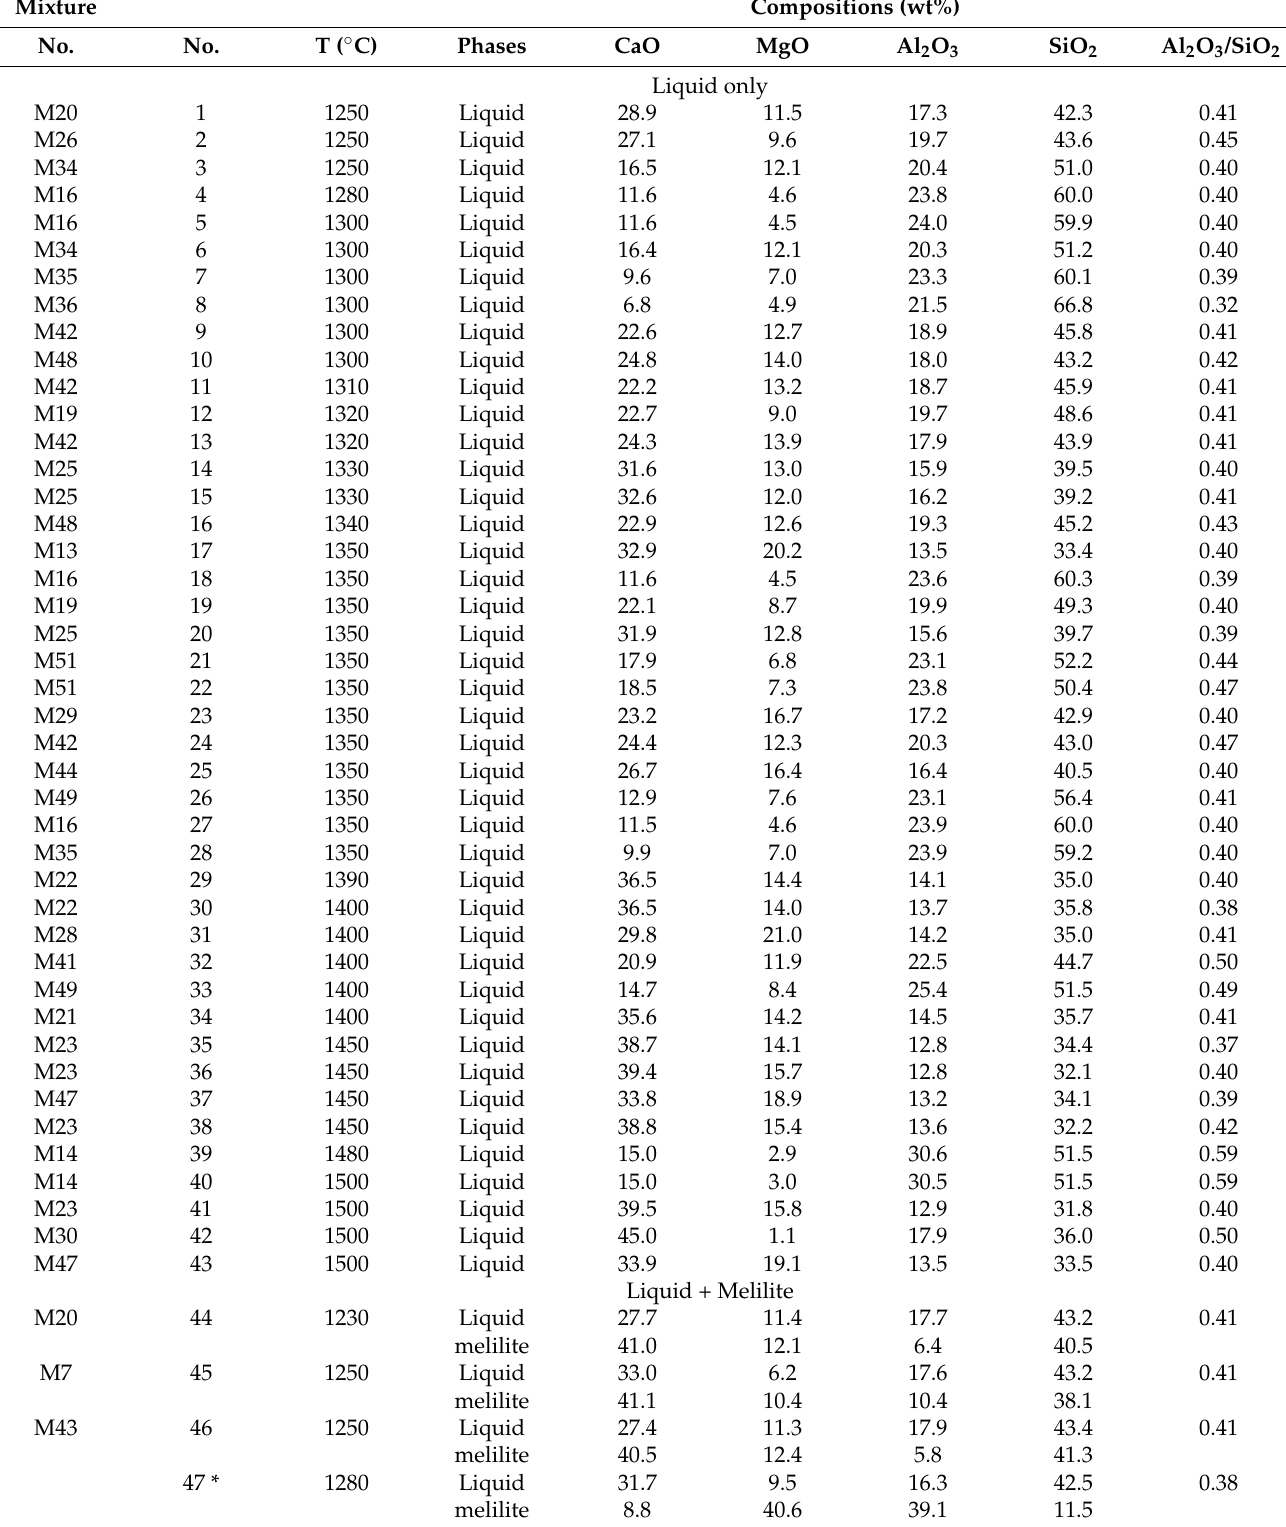
Table A2. Experimental Results in the System CaO-MgO-Al 2 O 3 -SiO 2 system with Al 2 O 3 /SiO 2 weight ratio of